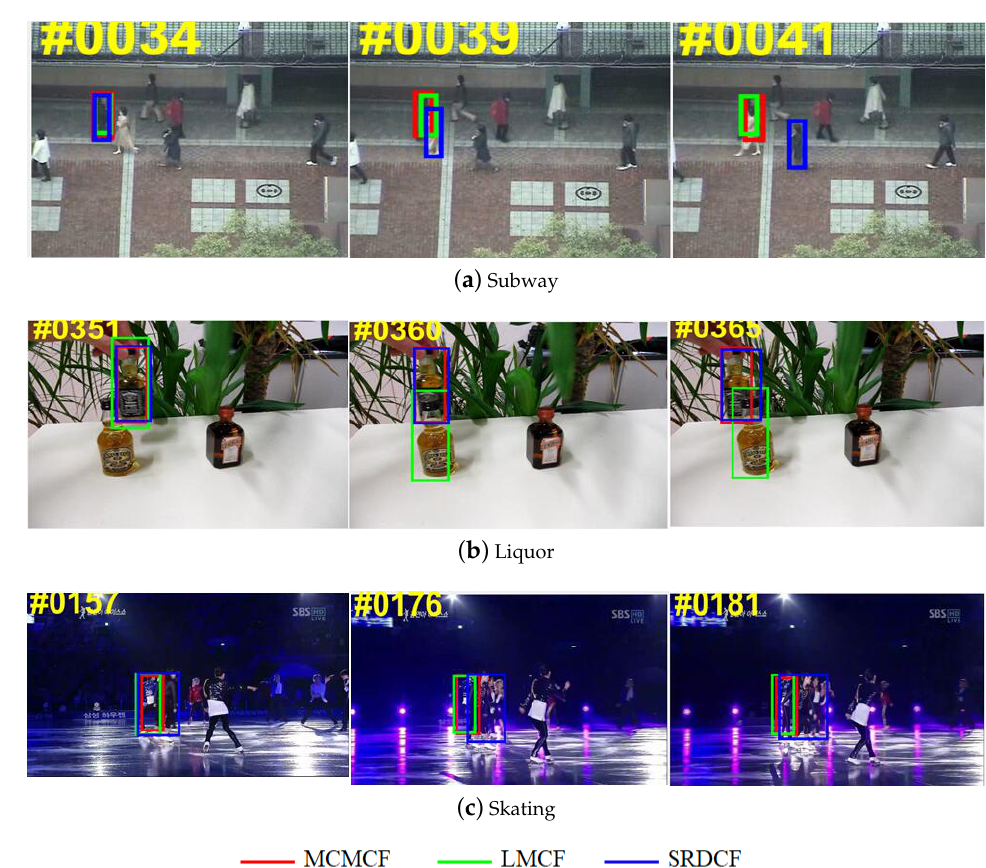
Bolded font in the table indicates the highest score in each column.